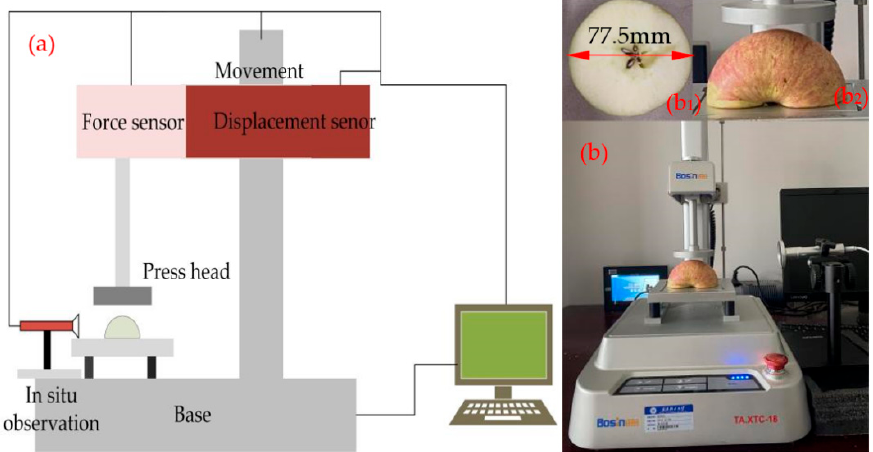
Figure 1. Schematic ( a ) and experimental setup ( b ) of the self-developed texture analyzer: ( b 1 ) TPA test sample; ( b 2 ) compressed test samples.